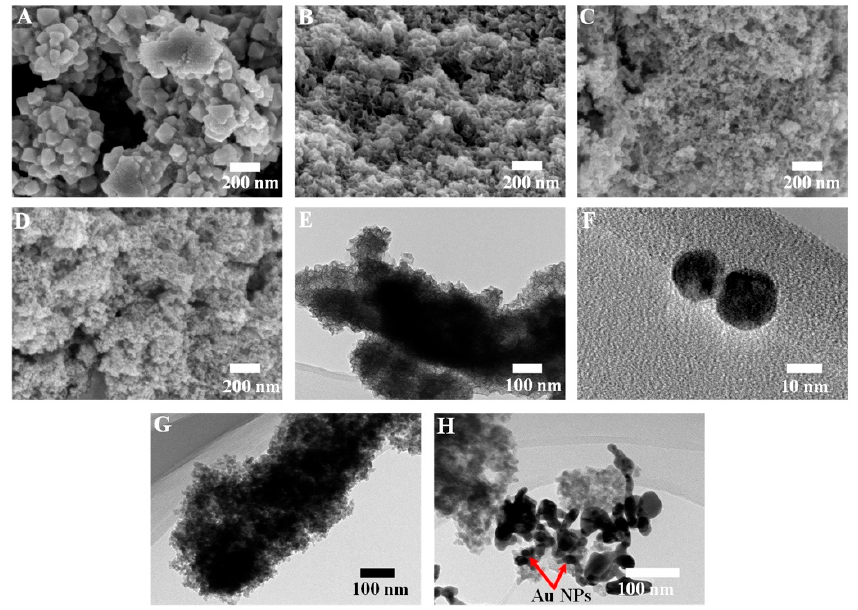
Figure 3. SEM images of Cu 2 O ( A) , MoS 2 ( B ), Cu 2 O@MoS 2 ( C ), Cu 2 O@MoS 2 -Au ( D ); TEM images of MoS 2 ( E ), AuNPs ( F ), Cu 2 O@MoS 2 ( G ), and Cu 2 O@MoS 2 -Au ( H ). of MoS 2 ( E ), AuNPs ( F ), Cu 2 O@MoS 2 ( G ), and Cu 2 O@MoS 2 -Au ( H